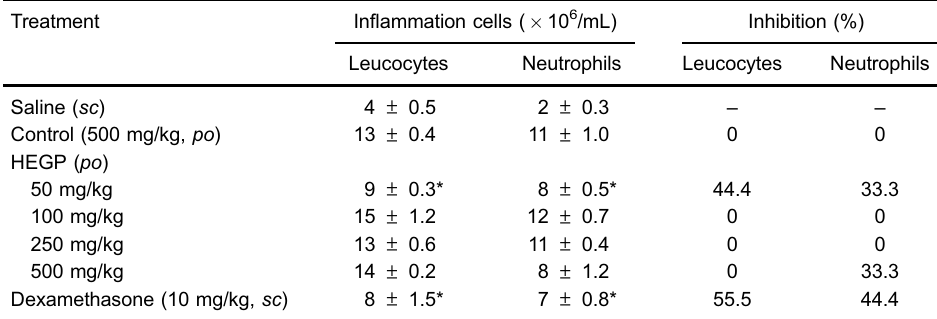
Table 3. Effects of hydroethanolic extract of Gochnatia (HEGP) on carrageenan-induced peritonitis in mice.